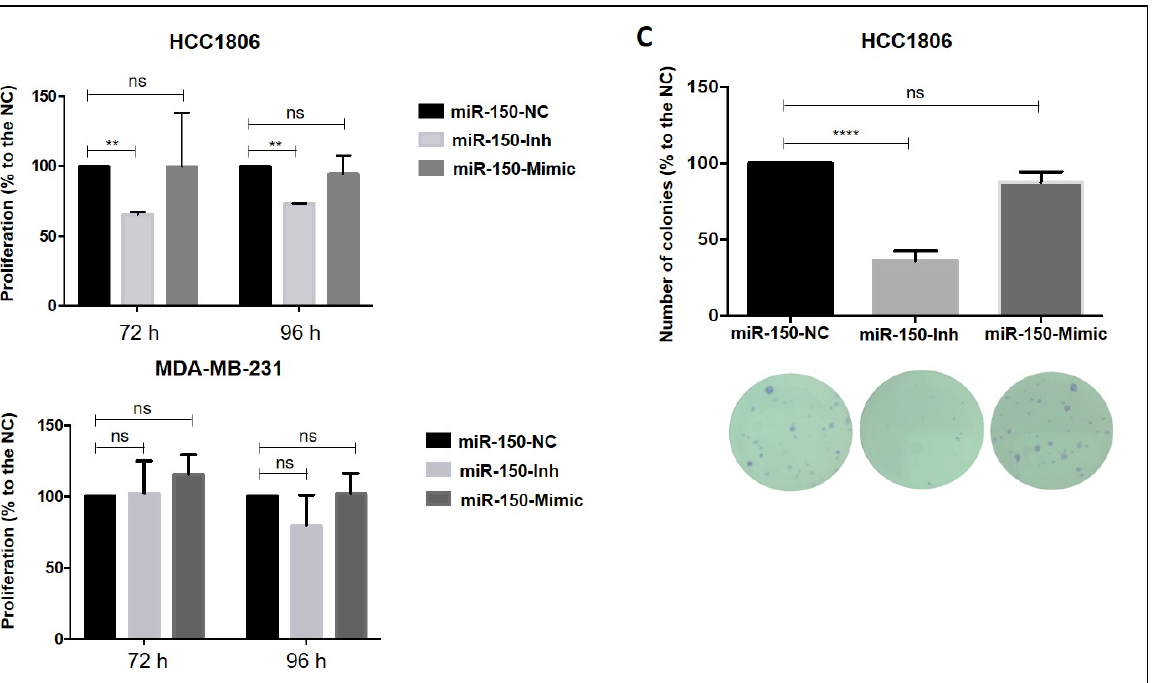
Figure 3. Cell proliferation and clonogenic growth assays in the TNBC transfected cells. ( A , C ) Inhibition of miR-150-5p reduced cell proliferation and clonogenicity in HCC1806 cells compared with NC cells. ( A , B ) In both cell lines, ectopic expression of miR-150-5p did not affect cell proliferation. Inh: Inhibitor; NC: negative control. ** p < 0.01; **** p < 0.0001; ns: not significant.